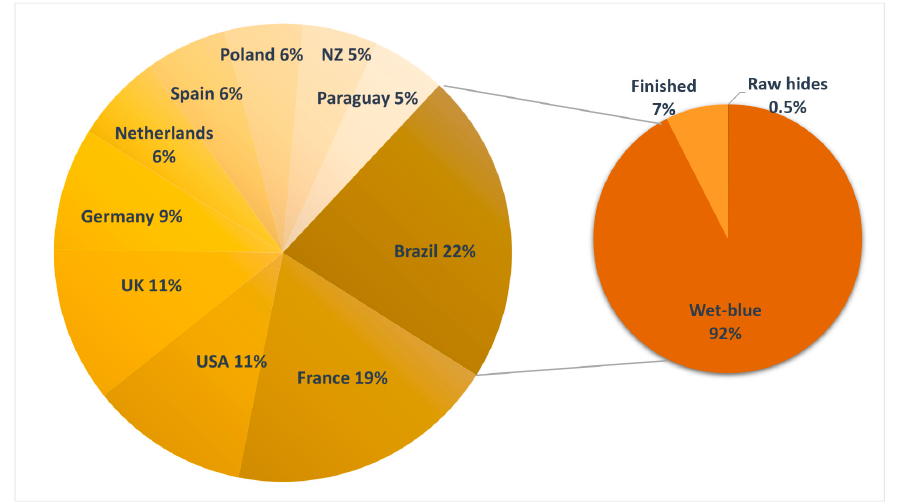
Figure 2. Top 10 Bovine hides and leather exporters to Italy in 2018 (as a % of the total exported net weight in kilotons) and the share of raw hides, wet-blue and finished leather exported by Brazil to Italy in 2018